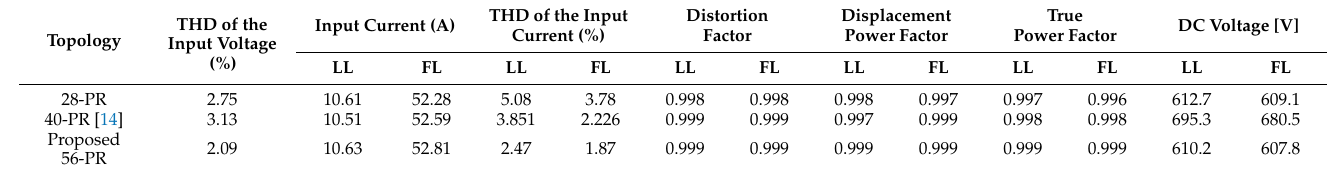
Table 4. Comparison of multi-pulse rectifiers with proposed 56-PR based on power quality indices.